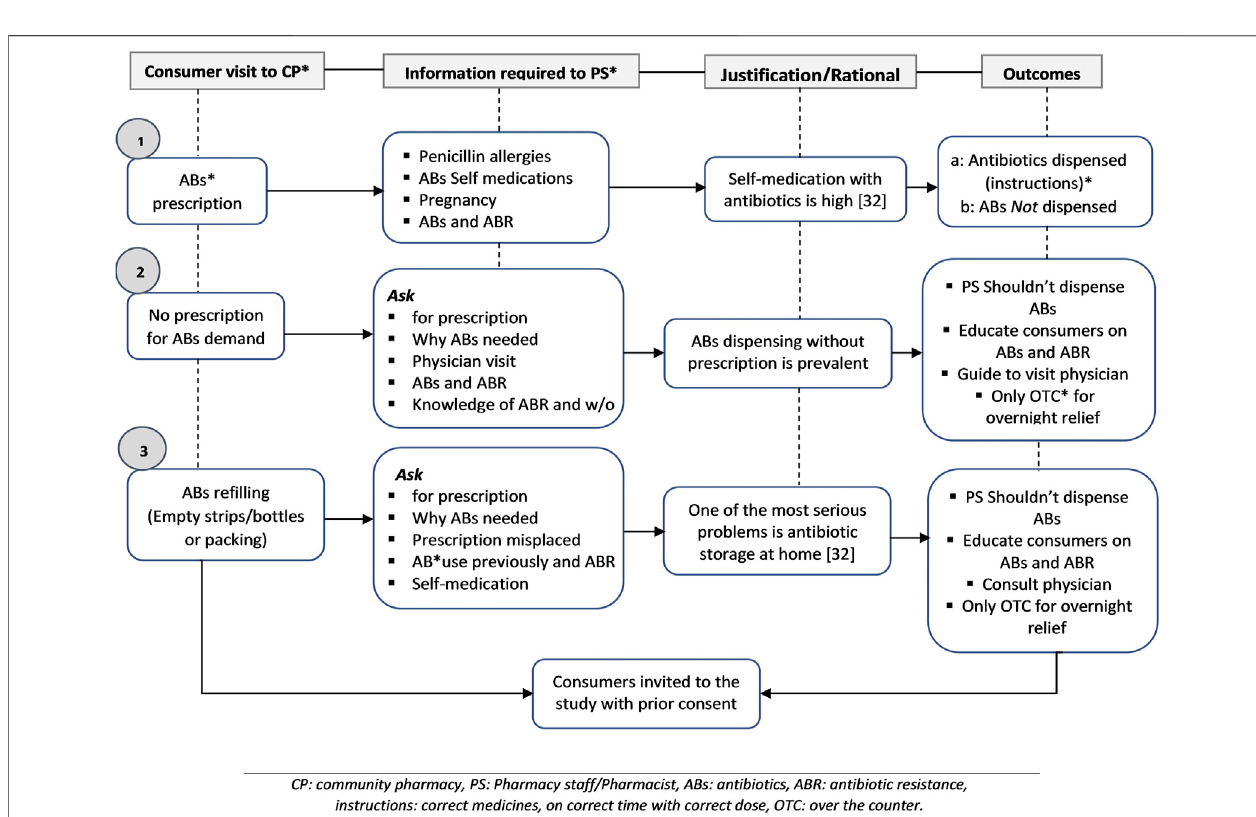
FIGURE 2 | Three scenarios for the consumer ’ s approach to the selected community pharmacy.